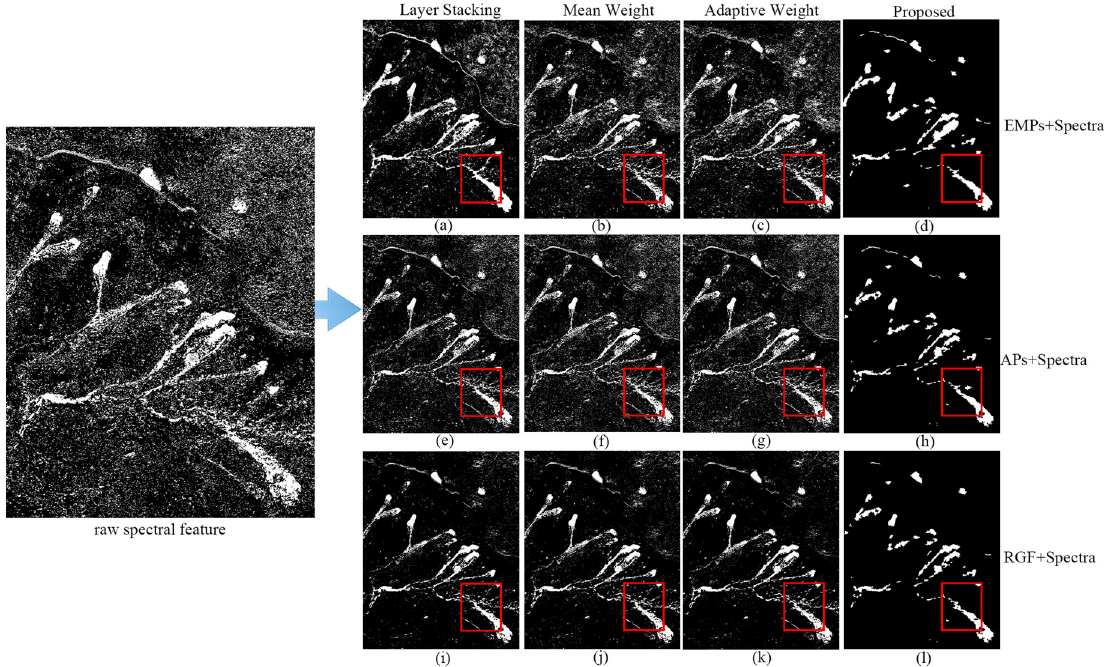
Figure 4. The comparison between the proposed framework and that using the raw spectral feature alone indicates that the results achieved by the proposed approach performed with less salt-and-pepper noise, as highlighted by the rectangle.